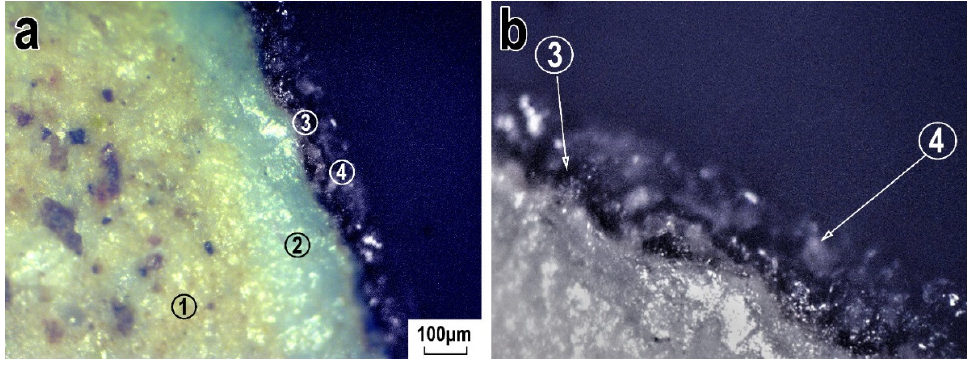
Figure 5. The OM image of the sample’s profile section showing layers sequence. ( a ): 1—the paste, 2—white slip, 3—black glaze, 4—transparent glaze. ( b ): 3—black glaze, 4—transparent glaze. The magnification 50×.